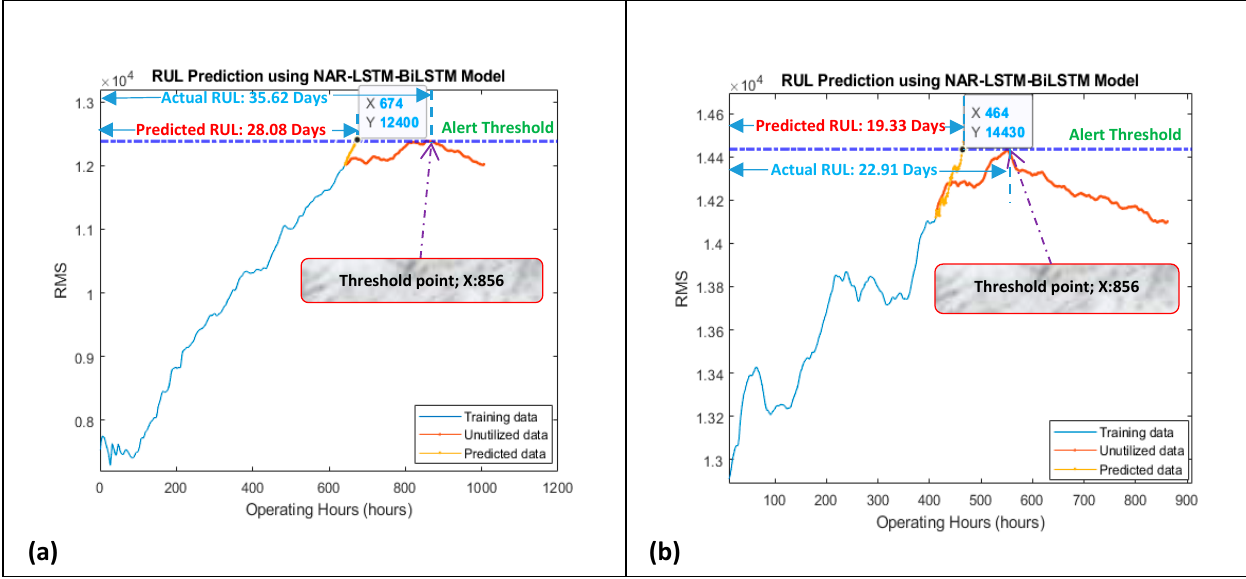
Figure 6. Prediction of overall RUL using 75% data of degradation trends for ( a ) dataset 2014 and ( b ) dataset